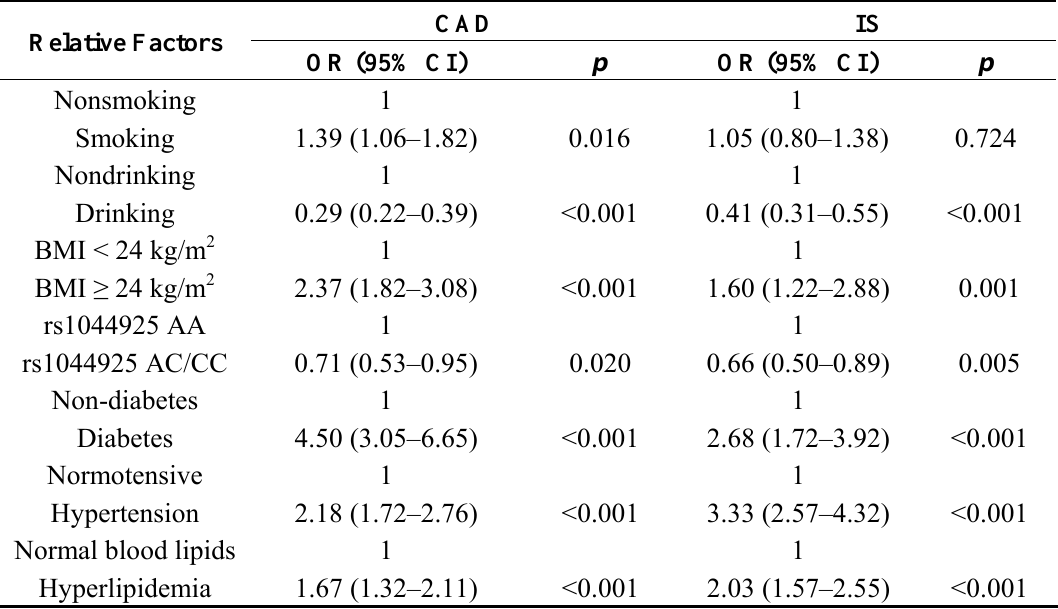
Table 4. The relative risk factors for CAD and